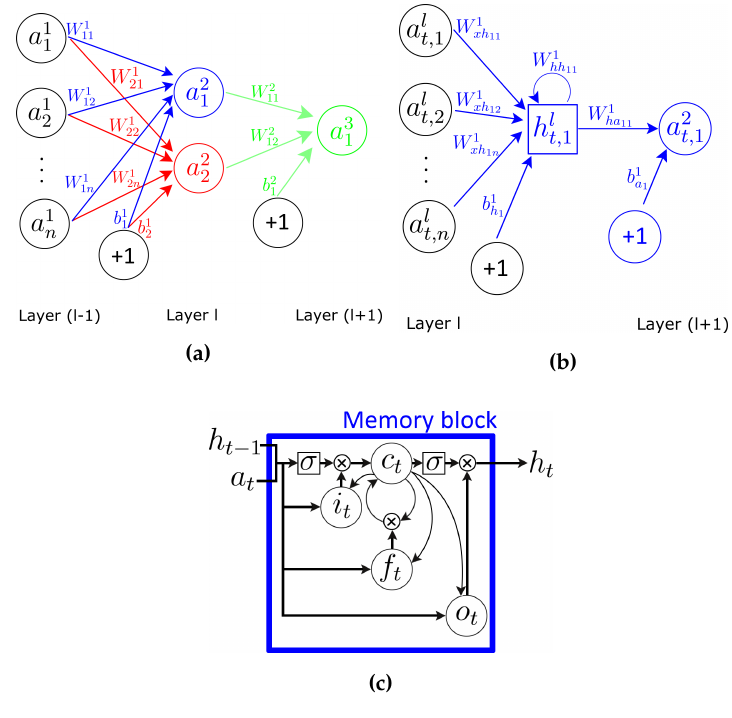
Figure 1. Different types of units in neural networks. ( a ) MLP with three dense layers; ( b ) recurrent neural network (RNN) with two dense layers. The activation and hidden value of the unit in layer p l ` 1 q are computed in the same time step t ; ( c ) The recurrent LSTM cell is an extension of RNNs, where the internal memory can be updated, erased or read